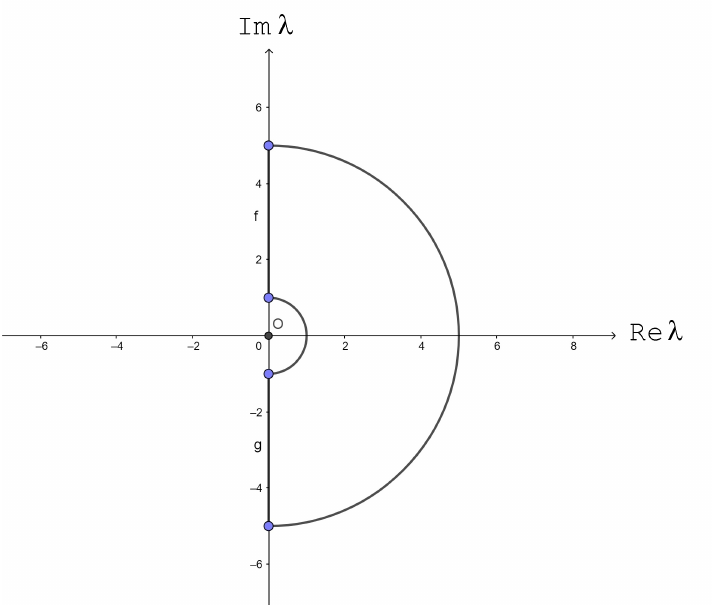
Figure 1. Path of γ curve enclosing all eigenvalues for a positive definite